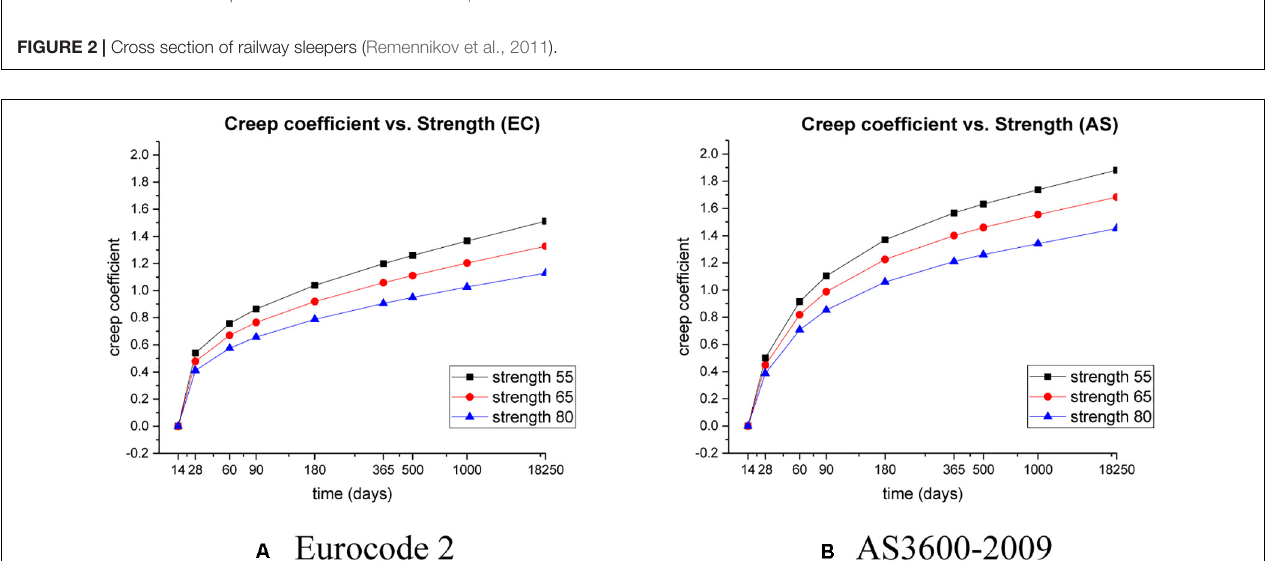
FIGURE 3 | Strength–creep relationship. (A) Euro Code 2 and (B) AS3600-2009.